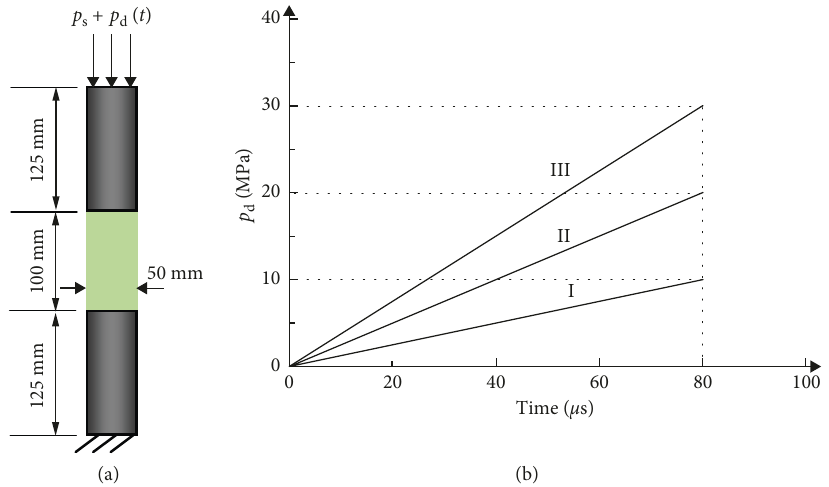
Figure 10: Numerical model for simulating rock damage and failure induced by combined rheological load and dynamic disturbance. (a) Geometries and loading conditions. (b) Incident stress waves: (I) p